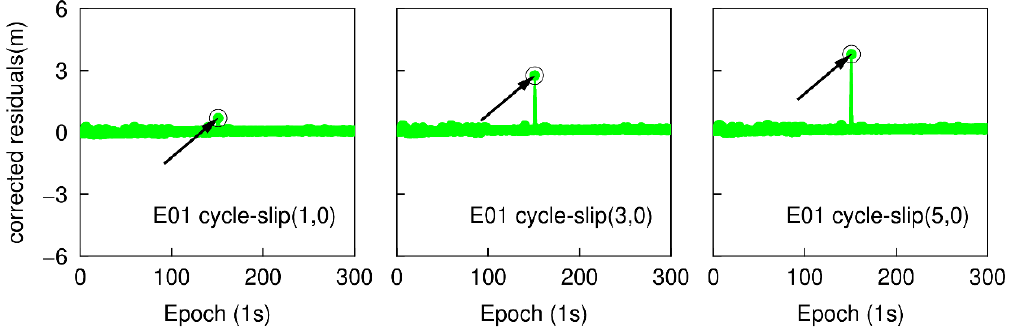
Figure 8. Small cycle-slip detection results by checking the largest residual for E01. Table 1. Summary of the small cycle-slips detection and correction